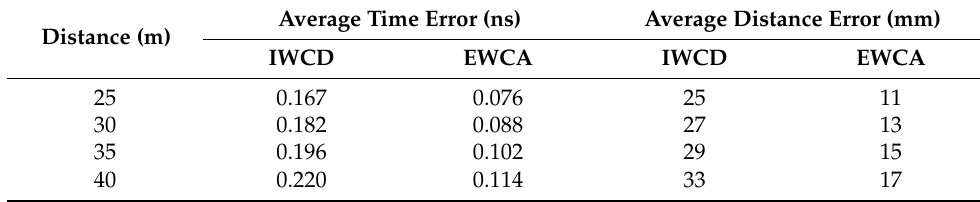
Table 3. Ranging results of the algorithms.